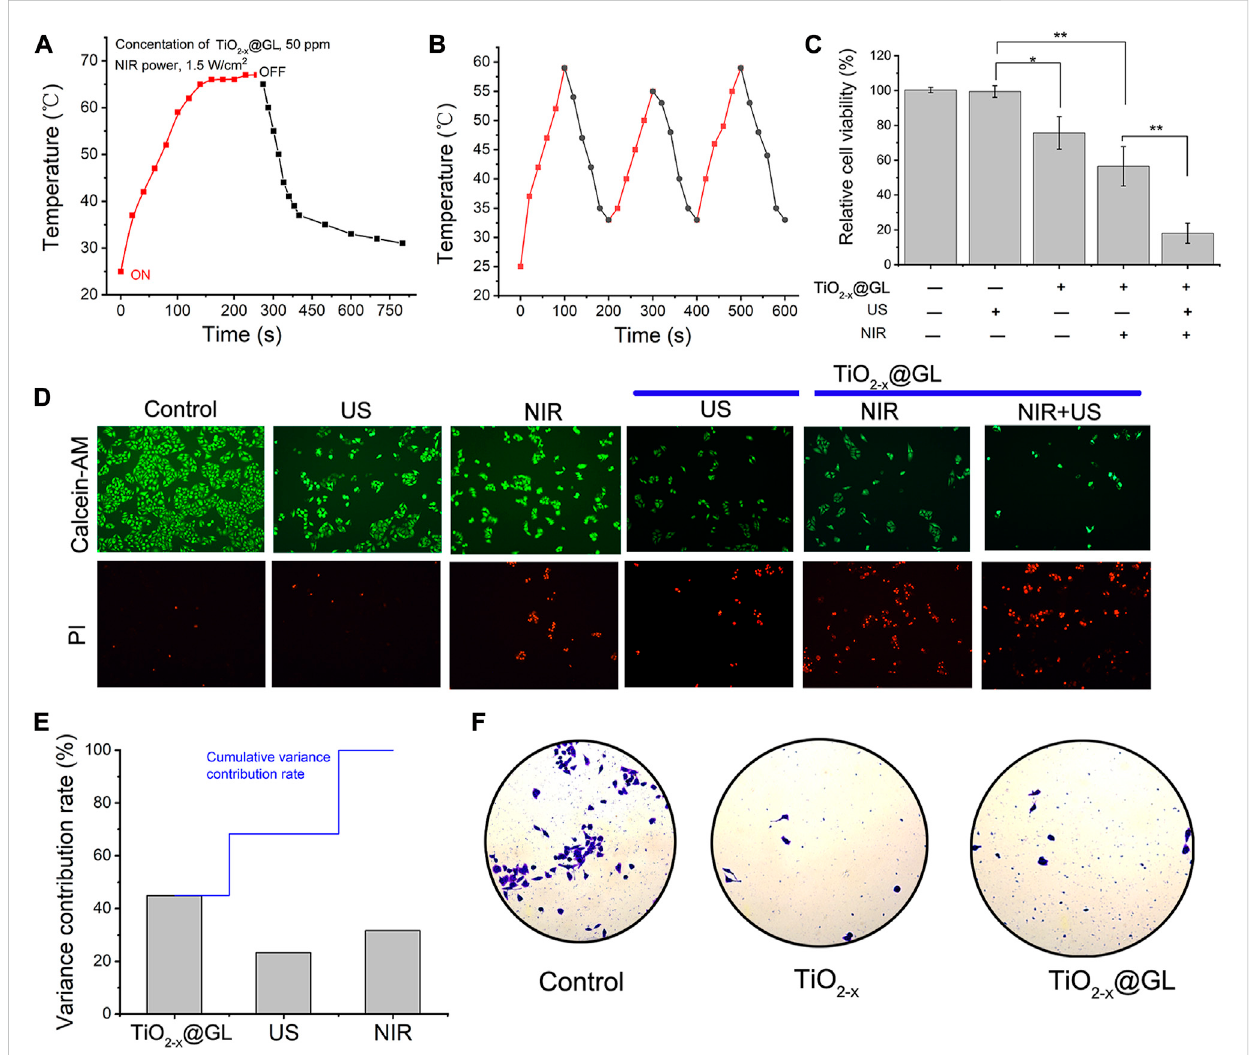
FIGURE 4 In vitro SDT/PTT-based synergistic cancer therapy. (A) Photothermal performance of the aqueous dispersion of TiO 2-x @GL (50 ppm) under NIR irradiation at a power intensity of 1.5 W/cm 2 for periods after US, and the temperature tended to stabilize when the laser cut off; (B) Heating curve of TiO 2 − x @GL dispersed in water for three cycles at a power intensity of 1.5 W/cm 2 ; (C) Relative cell viability of 4T1 cells after different treatments, including control (without treatment), TiO 2-x @GL only, US only, TiO 2 − x @GL combined with NIR, TiO 2-x @GL combined with US irradiation, and TiO 2-x @GL combinedwithNIR/UScoirradiation. (D) CLSMimagesof4T1cellsafterdifferenttreatments,whichwerestainedbyPI(red fl uorescence)andcalcein-AM (green fl uorescence). The scale bar is 40 μ m; (E) Variance contribution rate of TiO 2-x @GL, US and NIR; (F) Plate counting experiments of control, TiO 2-x , and TiO 2-x